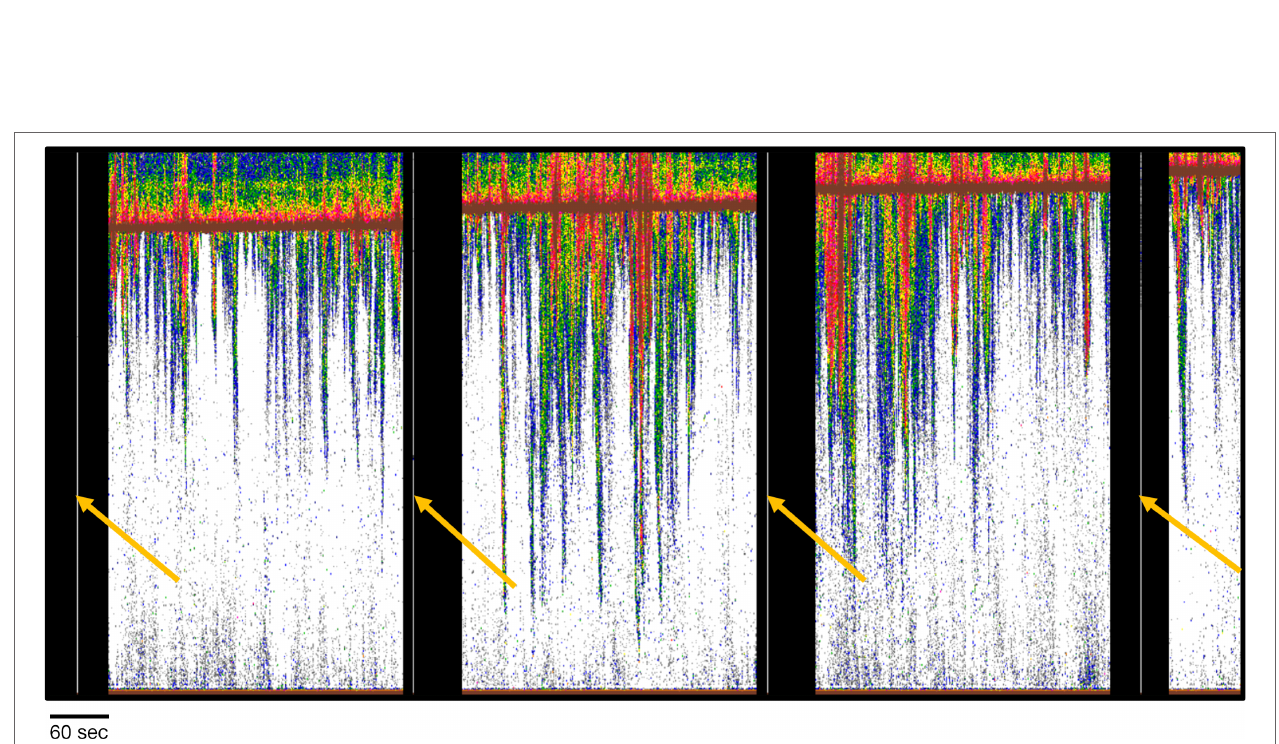
FIGURE 6 | Example showing appropriate and adequate placement of the surface line by Echofilter models: Upfacing@100ep (pink) and Bifacing@100ep (blue) indicated at A . The line placements include the 1 m offset required to eliminate bias from acoustic beam deadzone. For reference, the surface line, without offset, as defined by Echoview is also shown (red; line B ). Data: stationary data with echosounder in upfacing orientation, recorded for 5 minutes every half hour at the Minas Passage site.